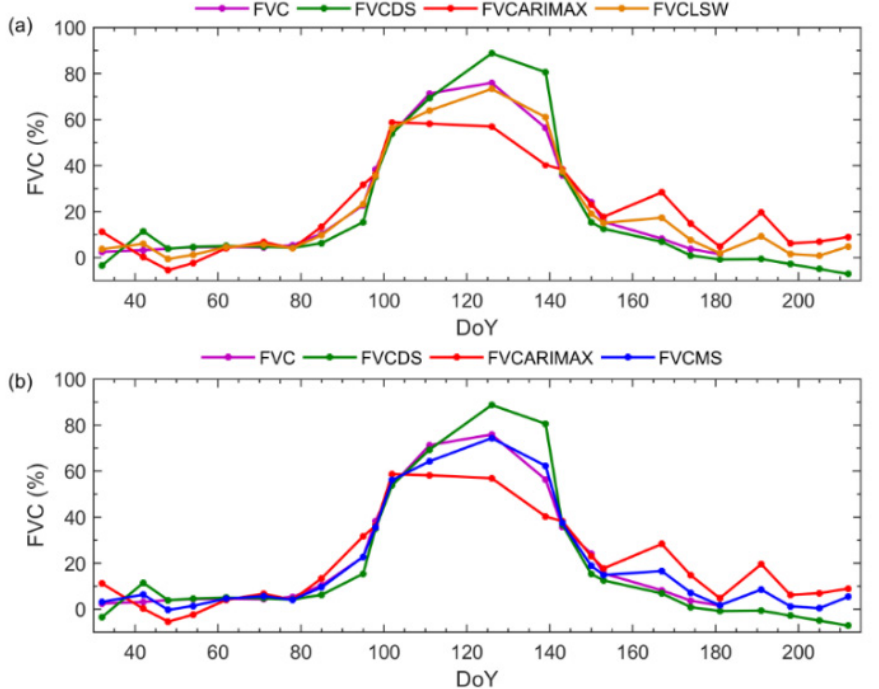
Figure 4. Combination prediction for biomass: ( a ) weighted least squares; ( b ) mean squared. B: interpolated data; BDS: double smoothing; BARIMAX: ARIMAX; BLSW: weighted least squares; BMS: mean squared.